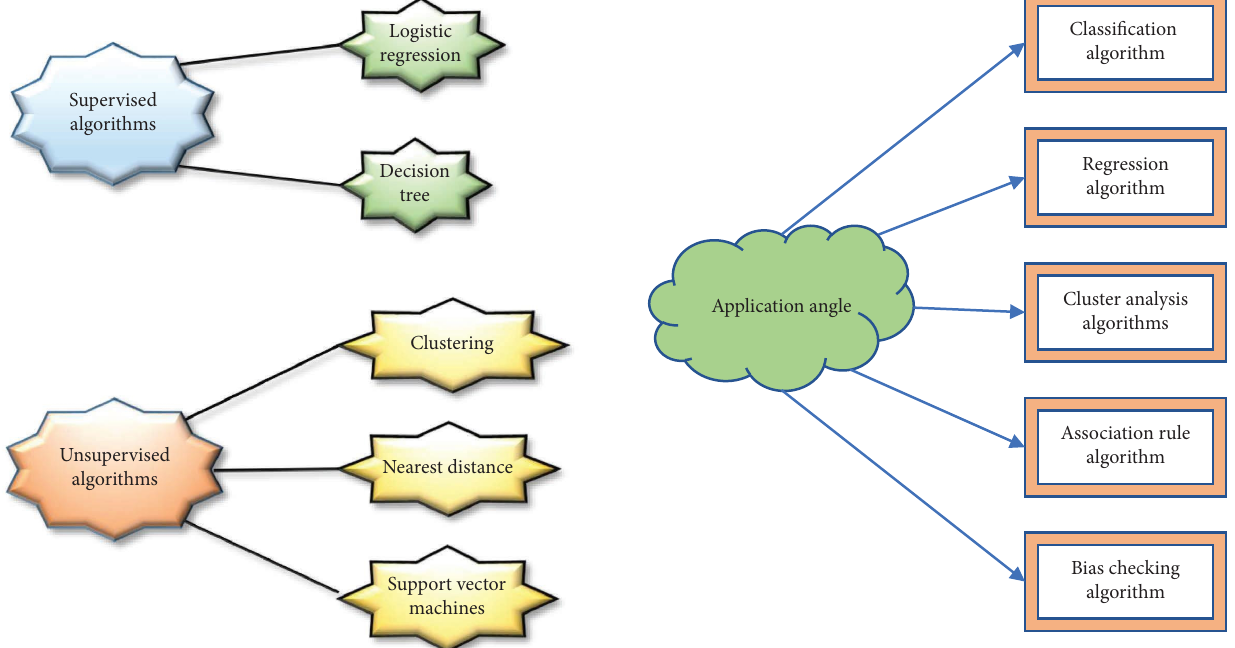
Figure 4: Classifcation of data mining techniques from an ap- plication